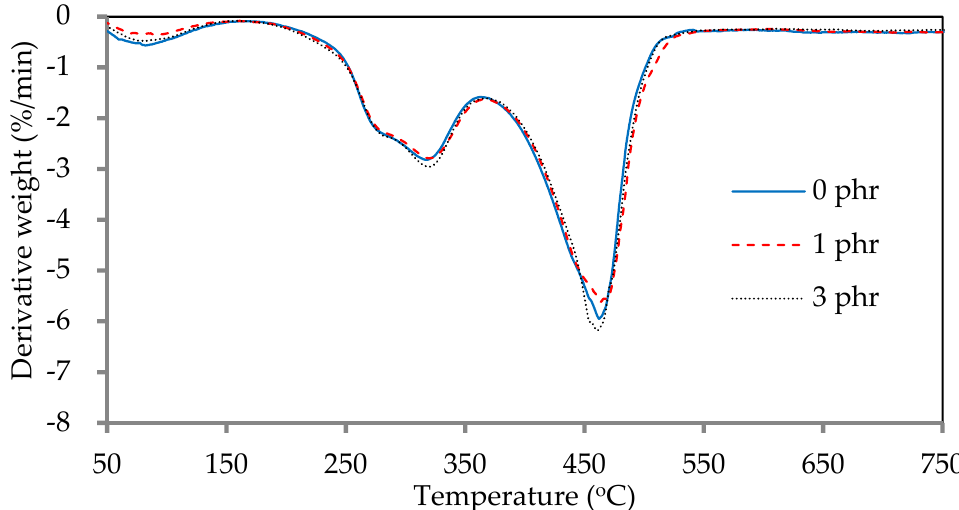
Figure 9. Derivative thermogravimetric diagrams of ROL films with various A. confusa heartwood extractive additions.